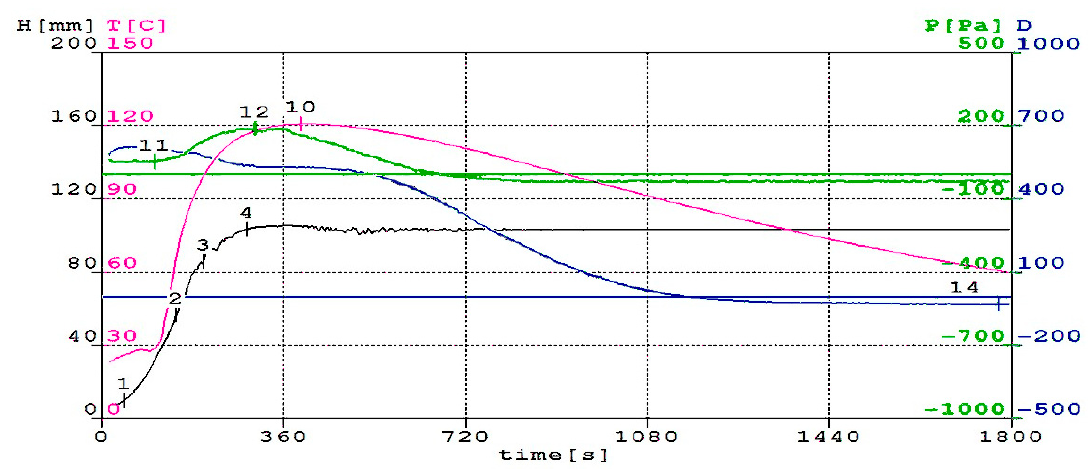
Figure 3. Change in height (H), temperature (T), pressure (p) and dielectric polarization (D) of reaction mixture during foaming process for M30 foam with 30 wt.% of biofiller.